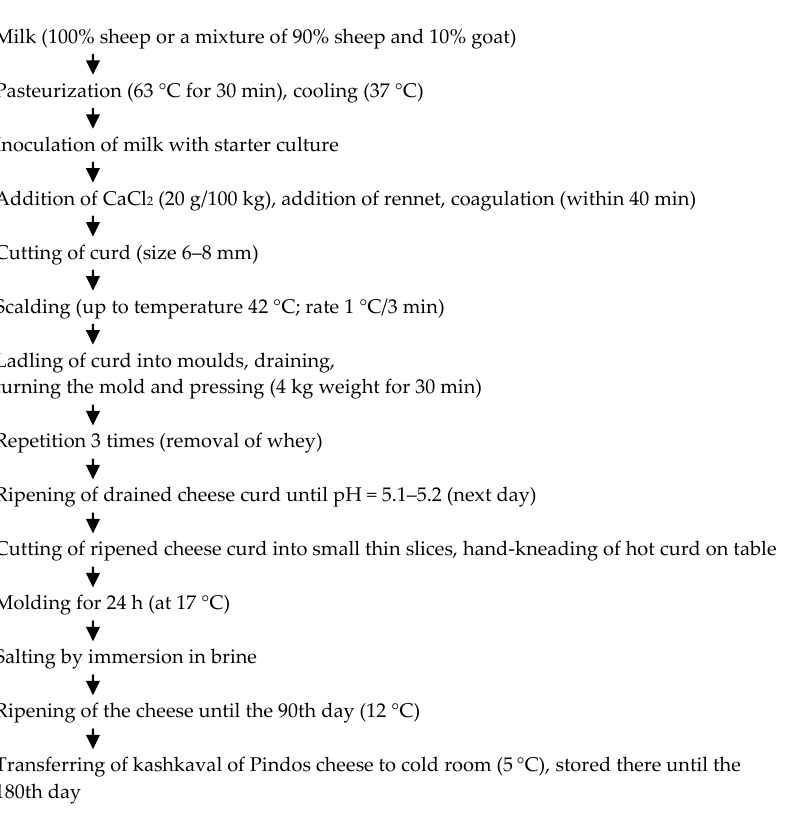
Figure 1. Manufacturing protocol of kashkaval of Pindos and Urda cheeses.